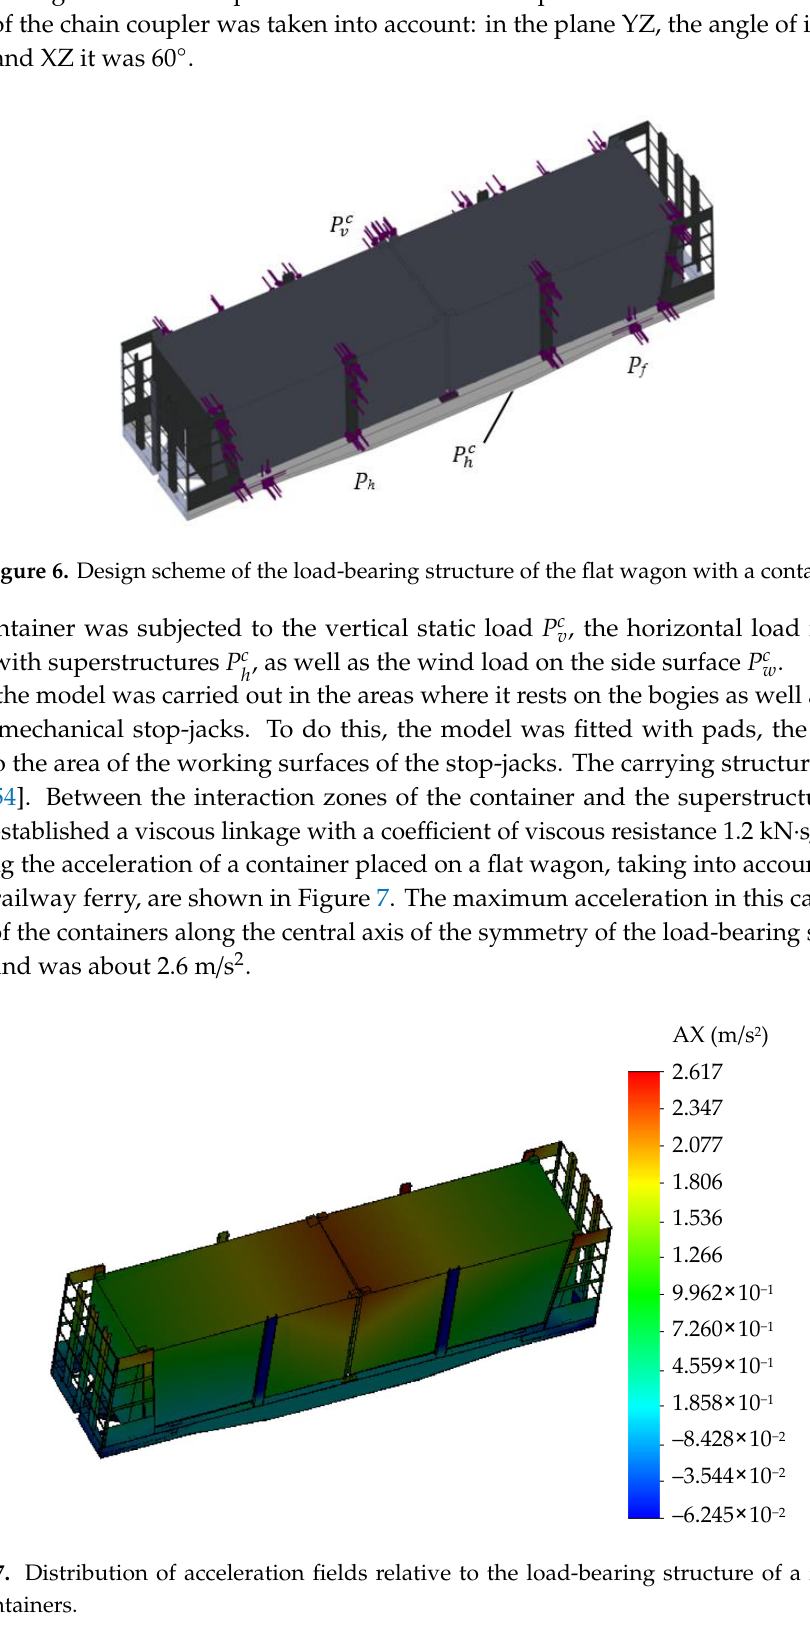
Figure 7. Distribution of acceleration fields relative to the load-bearing structure of a flat wagon with containers.